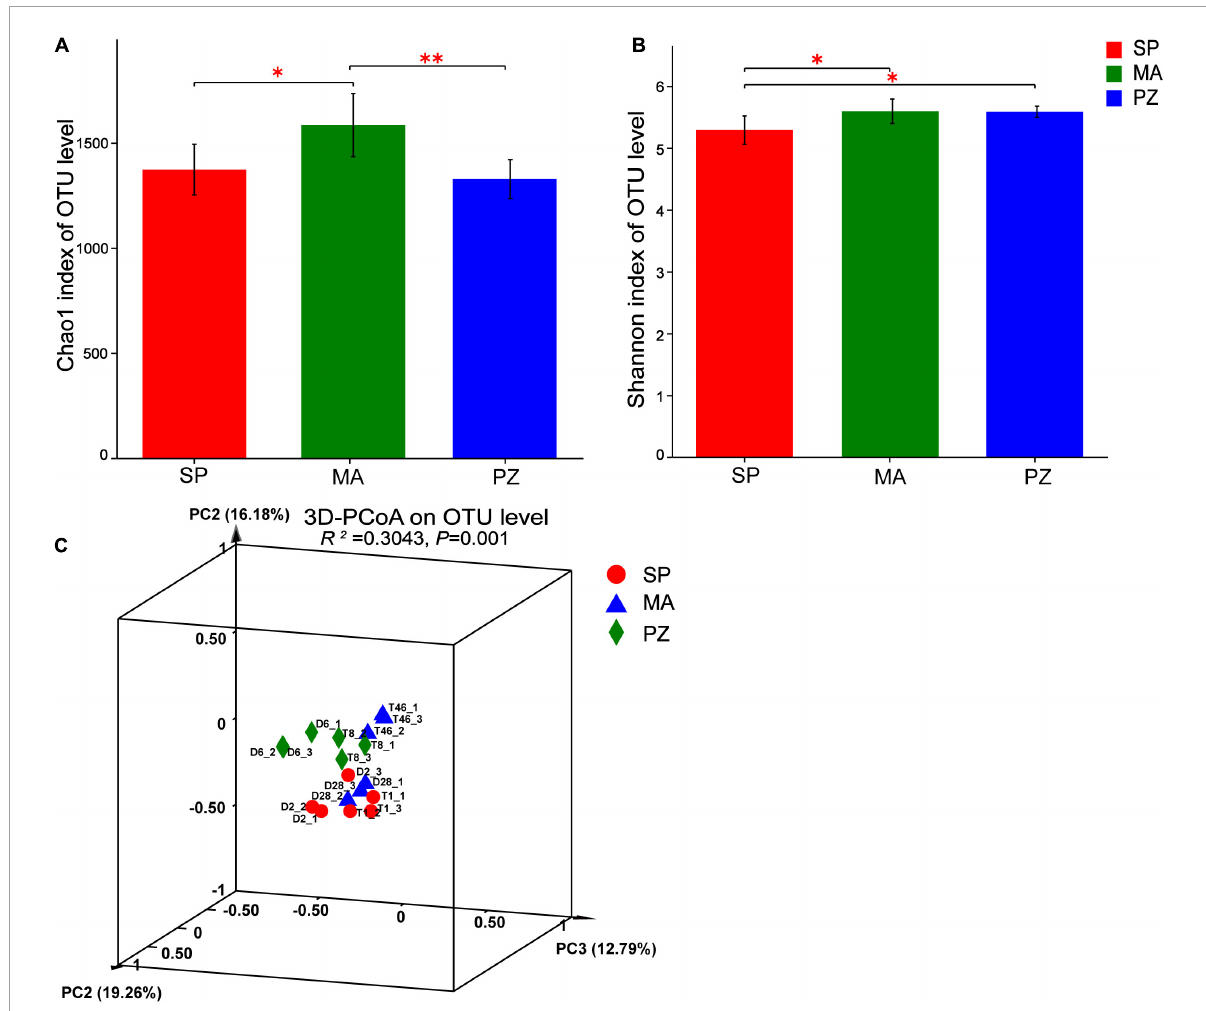
FIGURE3 Analysis of intergroup differences in α -diversity and β -diversity of intestinal bacteria in Shetland Pony (SP), Mongolian Wild Ass (MA), and Plain Zebra (PZ); (A) α -diversity analysis of intestinal bacteria between groups; (B) β -diversity analysis of intestinal bacteria between groups; (C) PCoA analysis graph; * P < 0.05 and ** P <